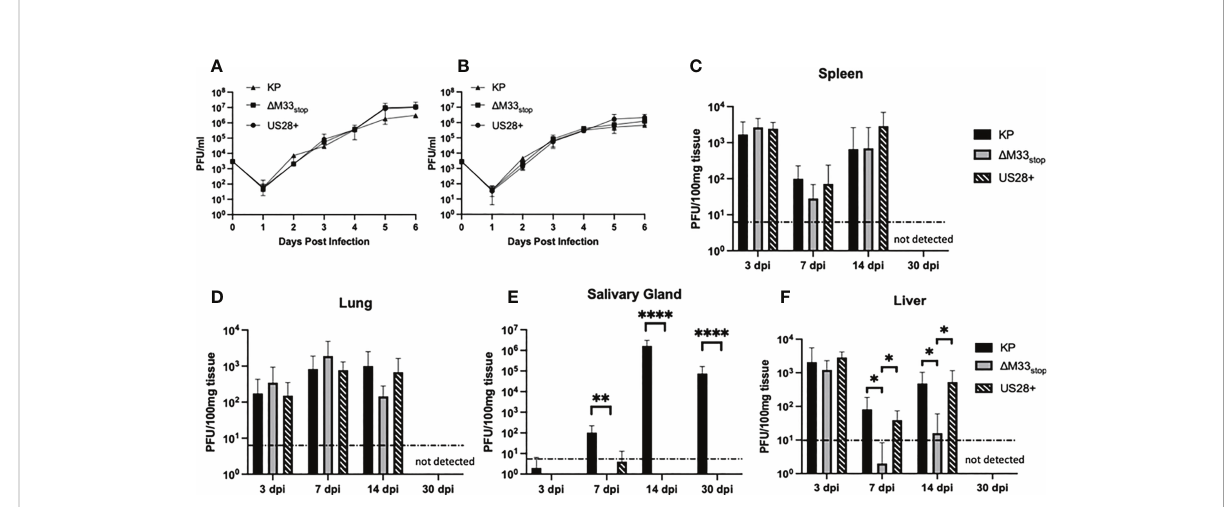
FIGURE 1 Growth kinetics of KP, D M33 stop, and US28+ MCMV are similar in vitro and in most tissues in vivo . (A, B) mSGM cells (A) or NIH 3T3 cells (B) were infected at an MOI of.01 and total virus was titered at 24 hour intervals (n=6). (C-F) BALB/c ByJ mice were inoculated I.P. with 1x10 6 PFU of KP, D M33 stop, or US28 + MCMV and sacri fi ced at 3, 7, 14, and 30 days post infection. Viral kinetics are shown in the spleen (C) , lungs (D) , salivary gland (E) , and liver (F) . Dotted line represents the limit of detection. Data presented are mean ± sd. Mouse experiments were conducted three times (3, 7, and 14 dpi; n=15) or once (30 dpi; n=5). Comparisons represent two-way ANOVA with signi fi cance indicated as: *, p<0.05; **, p<0.01; ****,